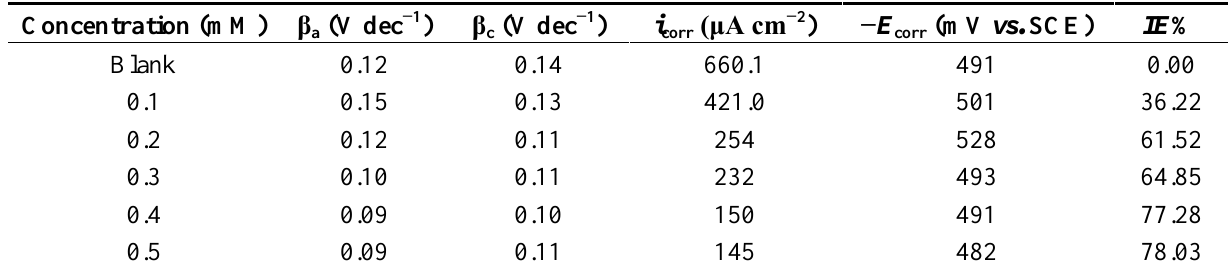
Table 1. Polarization parameters for mild steel in 1.0 M HCl with different concentrations of chlorocurcumin at 30